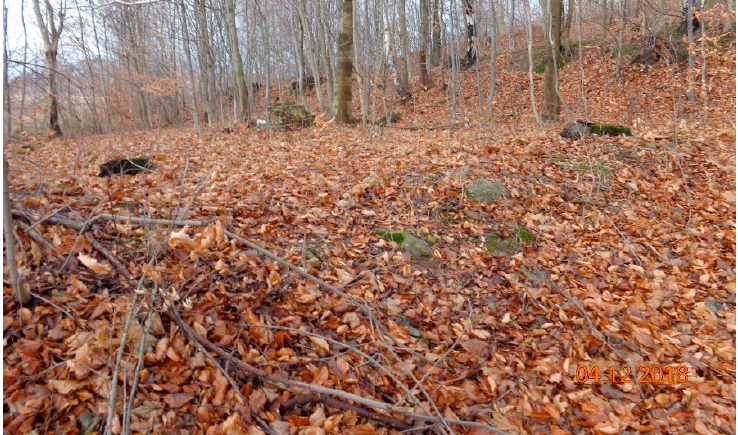
Figure 15. Artificially formed terraces with remains of a chimney, Krupp LZA Wüstegiersdorf; photo P. Lewandowski.